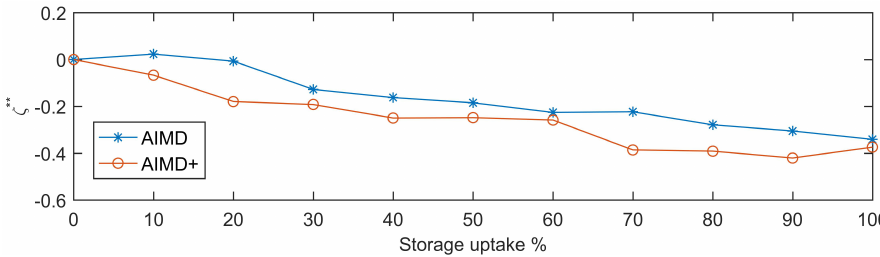
Figure 12. Average ζ ∗∗ storage